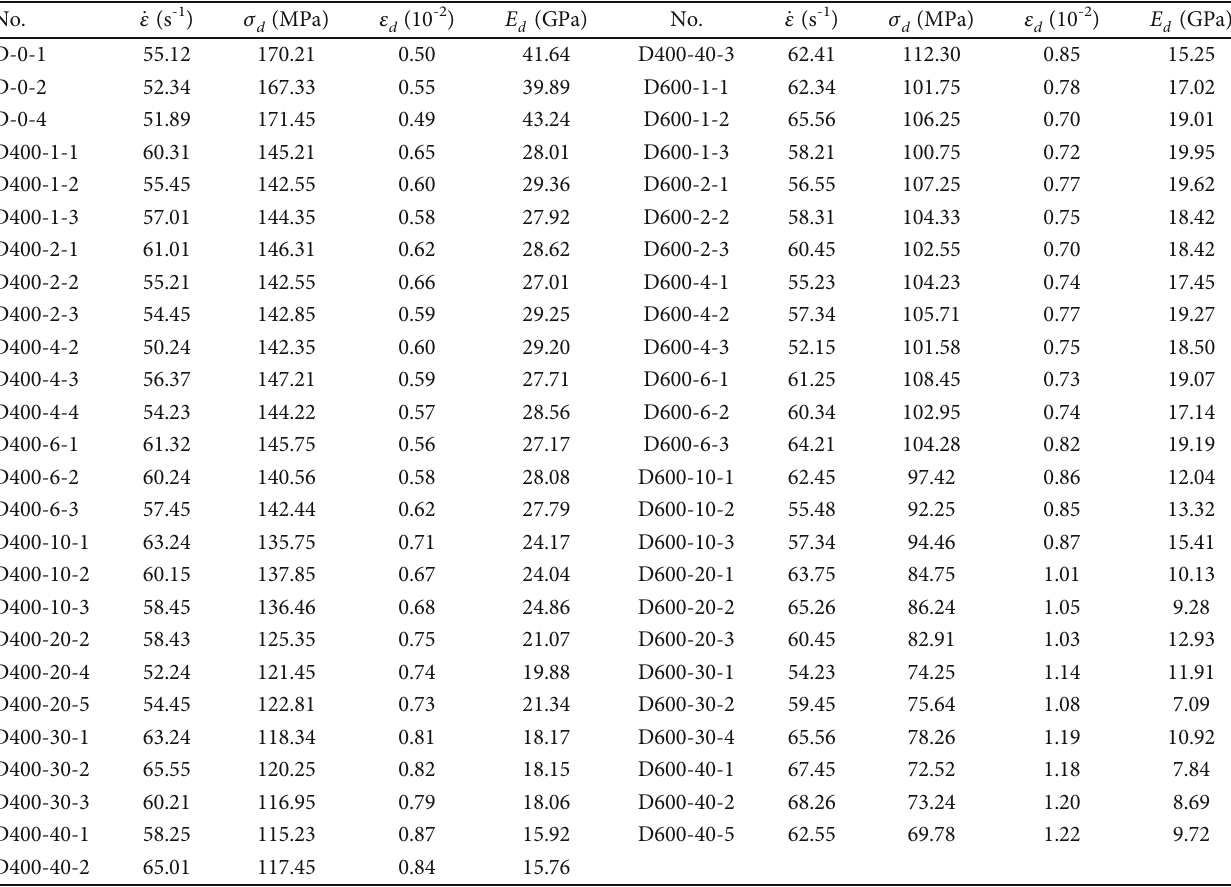
Table 4: The compressive properties of thermal shock treated granite specimens.